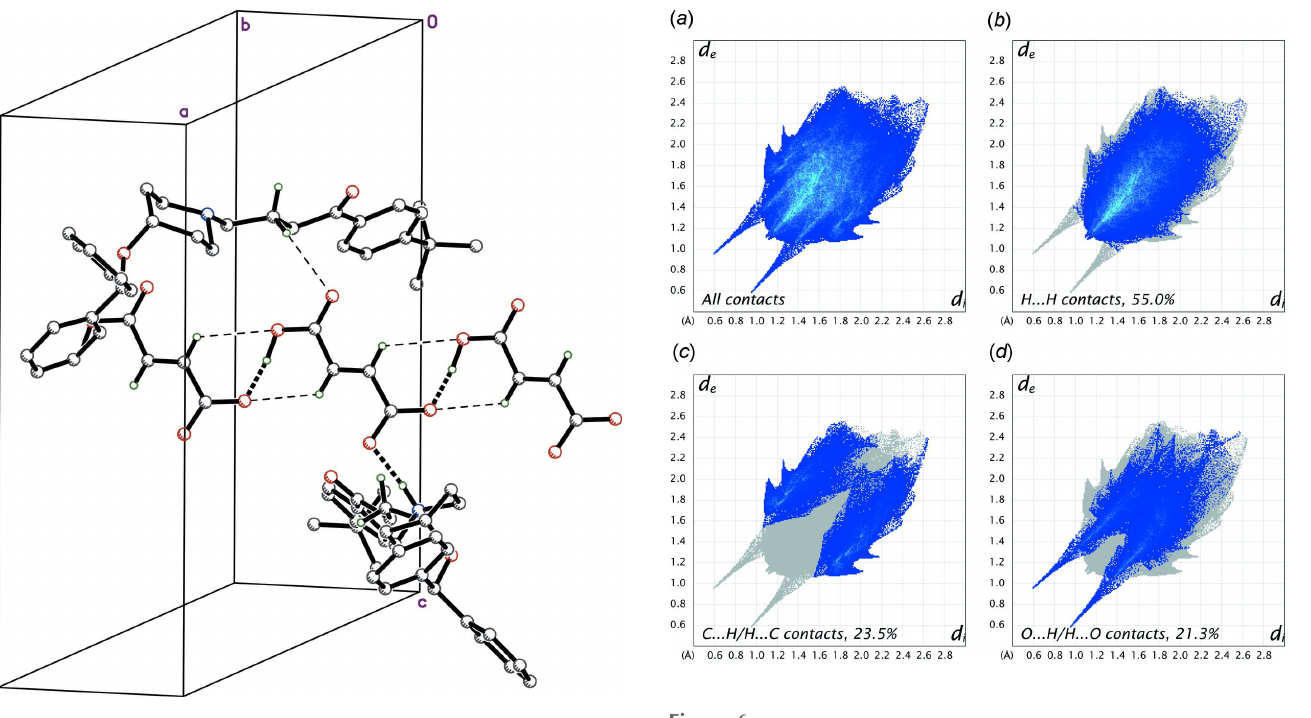
Figure 5 A partial packing plot showing three hydrogen fumarate anions connected into a chain running horizontally (parallel to b ) and the contacts of the central anion with ebastinium cations. Strong hydrogen bonds (O—H (cid:2)(cid:2)(cid:2) O, N—H (cid:2)(cid:2)(cid:2) O) are shown as thick dashed lines whereas weak C—H (cid:2)(cid:2)(cid:2) O hydrogen bonds are shown as thin dashed lines. Pairs of R 2 (6) ring motifs illustrate how the weak C—H (cid:2)(cid:2)(cid:2) O interactions augment 2 the strong O—H (cid:2)(cid:2)(cid:2) O hydrogen bond.